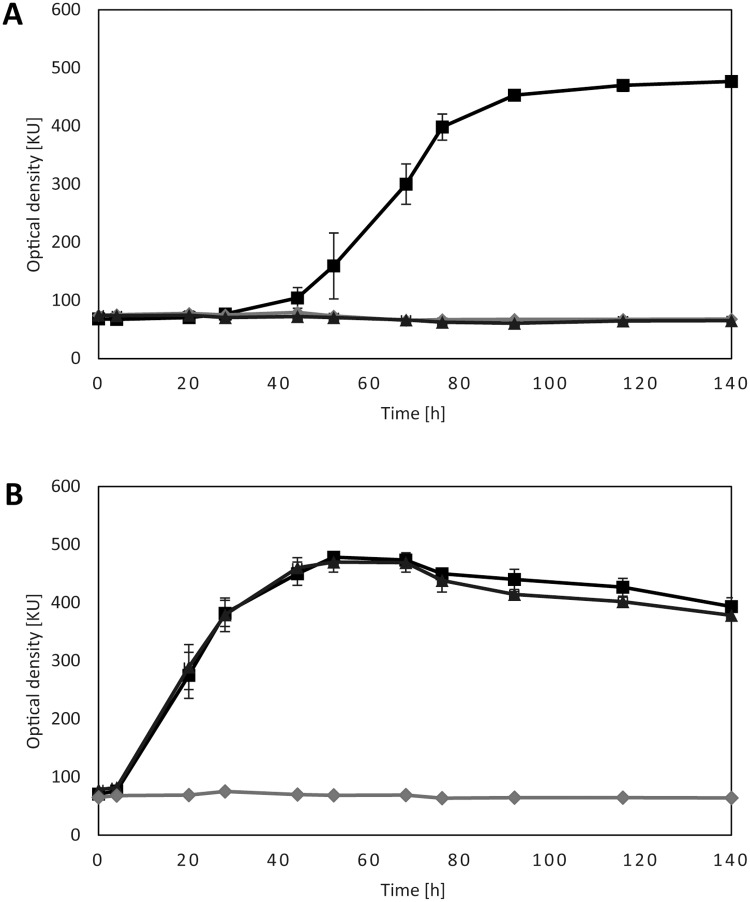
Growth of A. mimigardefordensis strain DPN7T, A. mimigardefordensis ΔxreΔlysR and A. mimigardefordensis ΔxreΔprpC, with 3,3´-ditiodipropionate (A) and propionate (B).A. mimigardefordensis strain DPN7T (squares), A. mimigardefordensis ΔxreΔlysR (triangles), A. mimigardefordensis ΔxreΔprpC (diamonds). All experiments were carried out in triplicate, bars indicate the standard deviation.